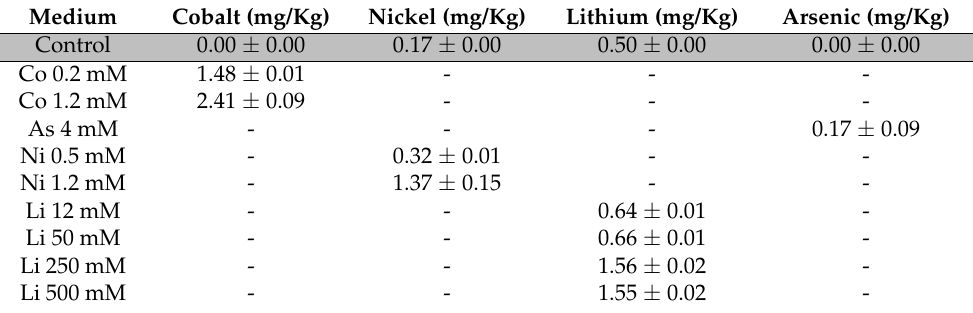
Table 6. Detection of intracellular metal ion accumulation by inductively coupled plasma